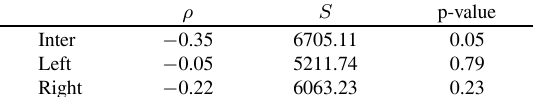
Table 6 Correlations of averaged EEG mutual information (inter-hemispher- ic, left and right hemisphere) with duration of the illness. Correlation is quanti fi ed using Spearman’s ρ and tested using rank statistics ( S